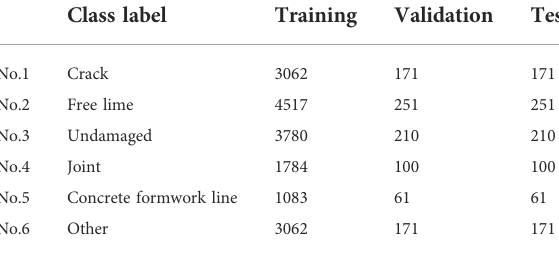
TABLE 1 Classi fi ed targets and Number of